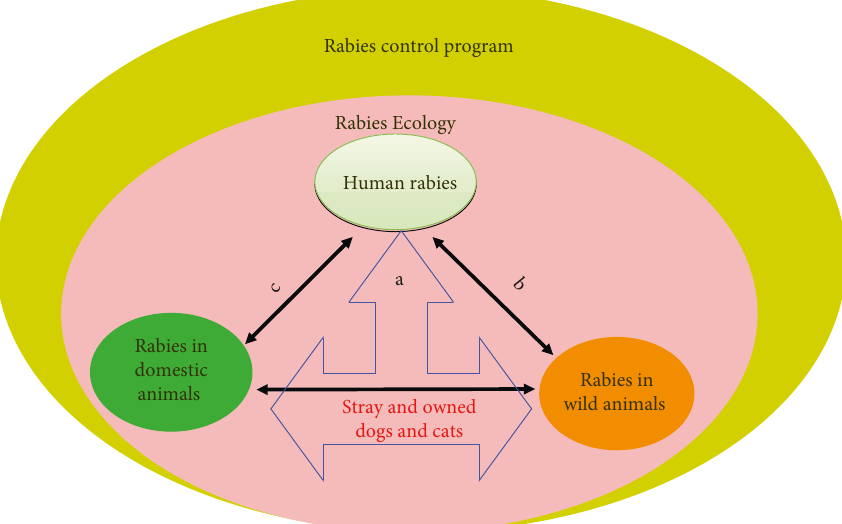
Figure 1: Sustainable rabies control plan. (a, b, c) Routes of rabies